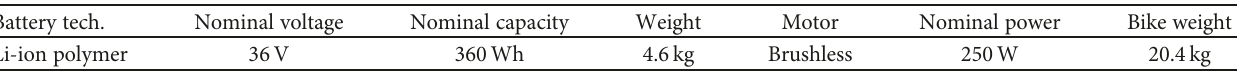
Table 2: e-bike speci fi cations.